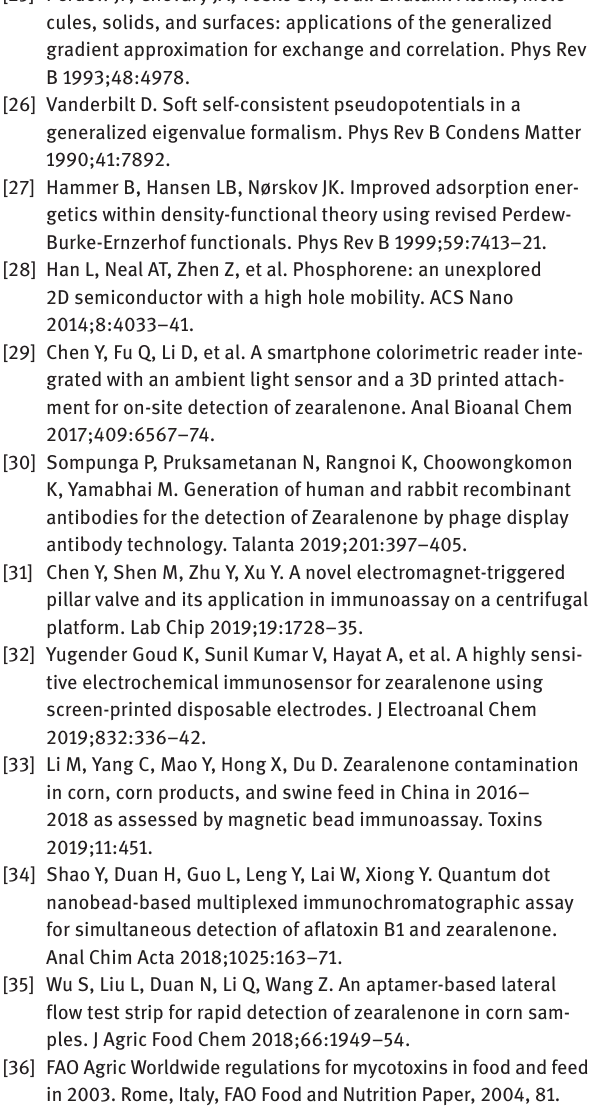
Supplementary Material: The online version of this article